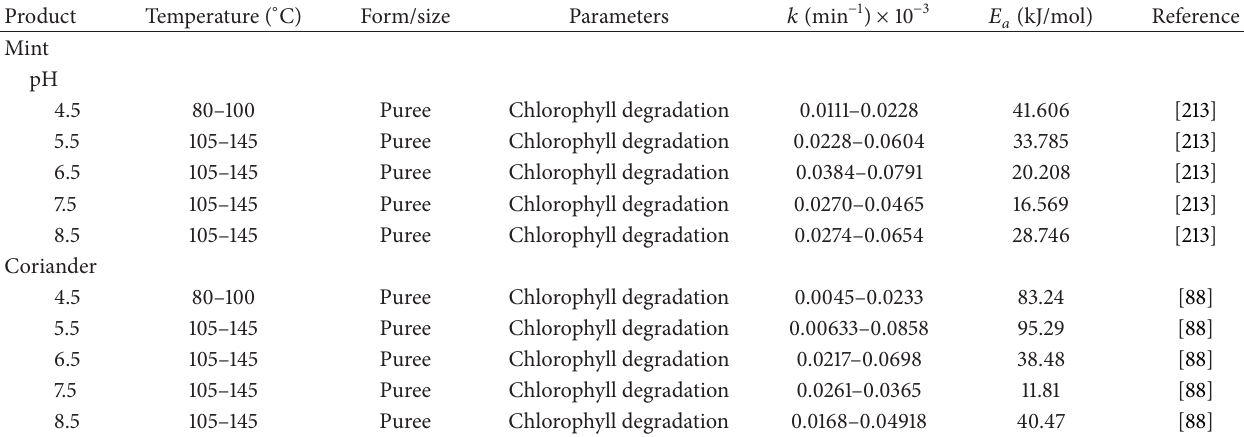
Table 5: Kinetic parameters associated with chlorophyll and color degradation in mint and coriander at different pH and temperatures. Product